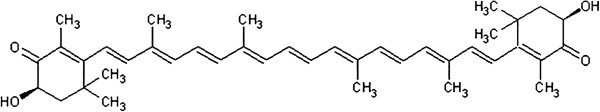
Chemical structure of Astaxanthin.